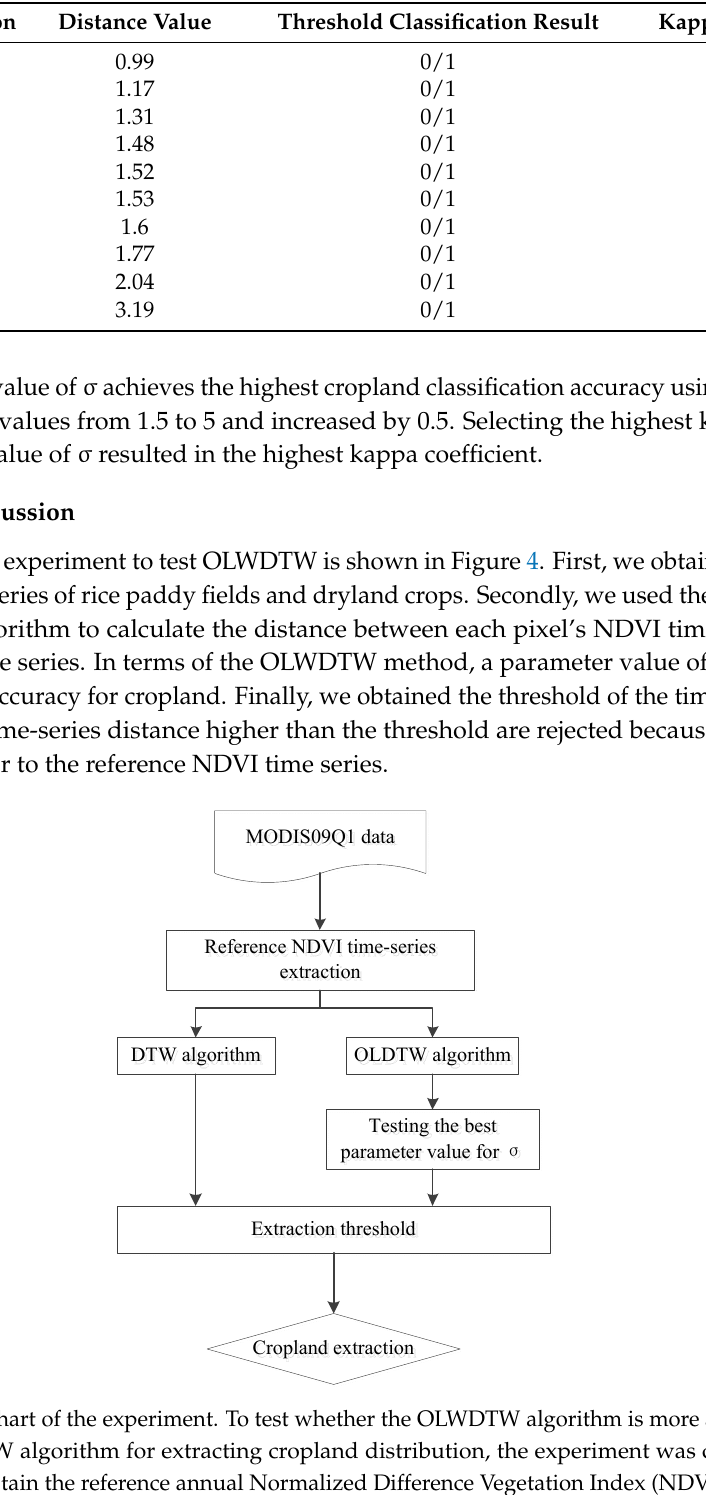
Table 3. Demonstration of the selection of the threshold value.